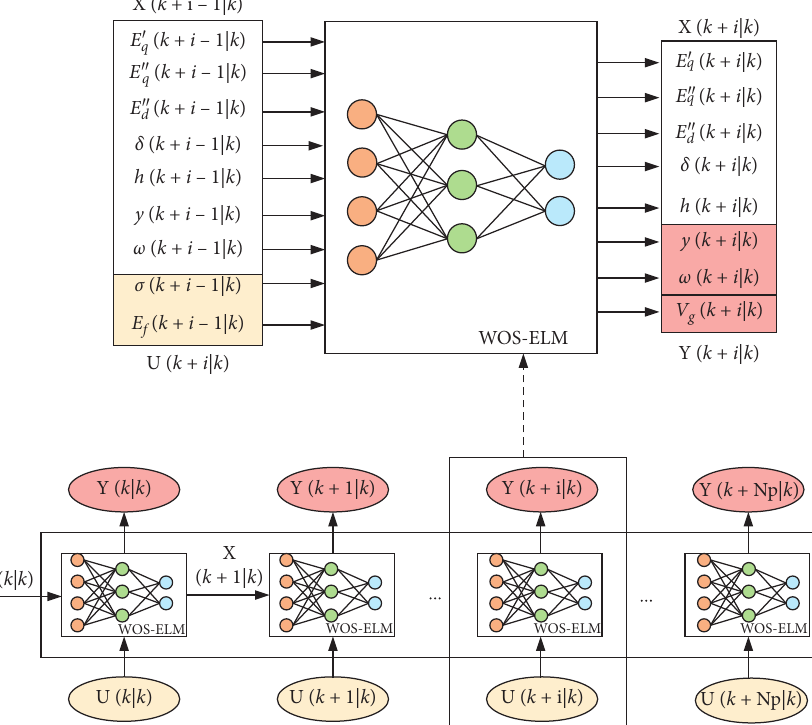
Figure 10: WOS-ELM based output prediction process in kth sampling